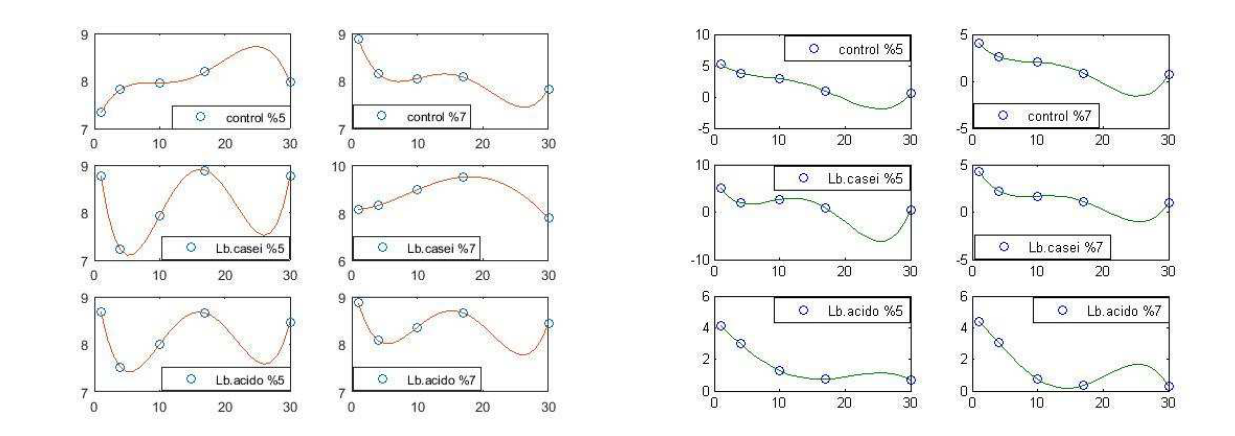
Figure 10. The graphics of the membership functions for yeast and mold numbers (the x-axis represent the days and the y-axis represent the yeast and mold